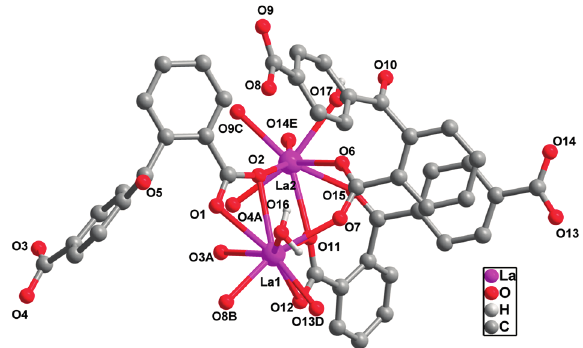
Figure 1. The coordination environment of La (III) center of 1 . Symmetry codes, A: − x , − y + 2, − z ; B: − x , − y + 1, − z ; C: − x , y + 1/2, − z + 1/2; D: − x + 1, − y + 1, − z ; E: − x + 1, y + 1/2, − z + 1/2. All H atoms are omitted for clarity.